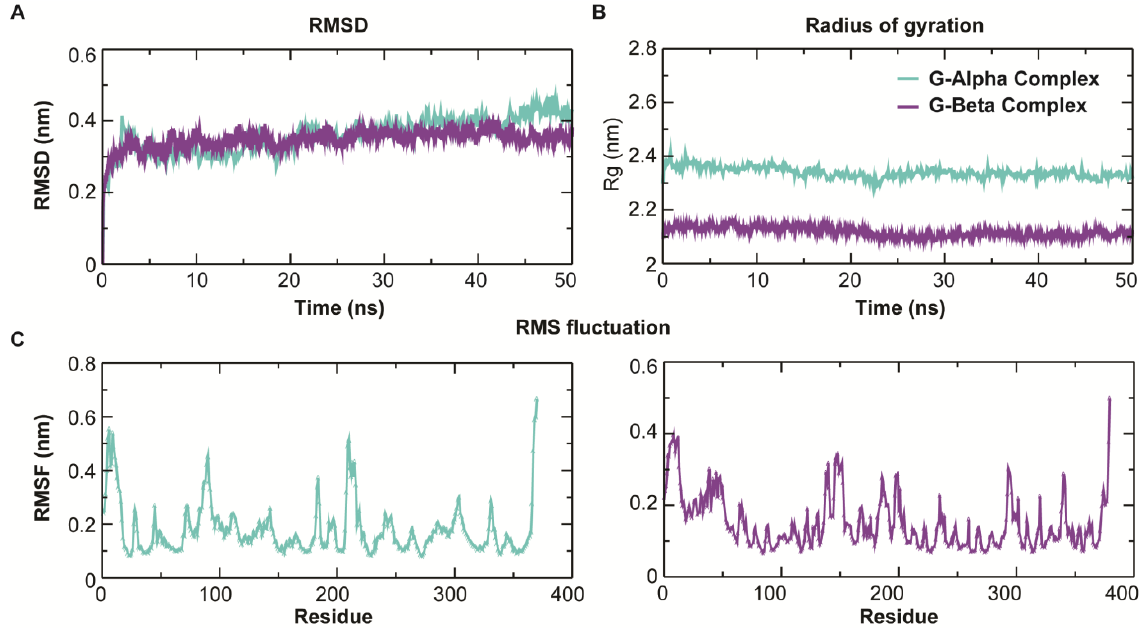
Figure 5. Intrinsic dynamics stability parameters of the G-alpha and G-beta subunit Bipolaroxin complexes during 50 ns MD simulation. ( A ) Root mean square deviation (RMSD) of backbone atoms of the modeled G-alpha subunit and experimental beta subunit in complexes with Bipolaroxin during 50 ns MD. ( B ) The compactness of the trajectory by calculating the radius of gyration (R g ) of the proteins during 50 ns MD in aqueous solution. ( C ) The root mean square fluctuation (RMSF) for C α atoms of the G-alpha (left) and G-beta (right) complex systems.